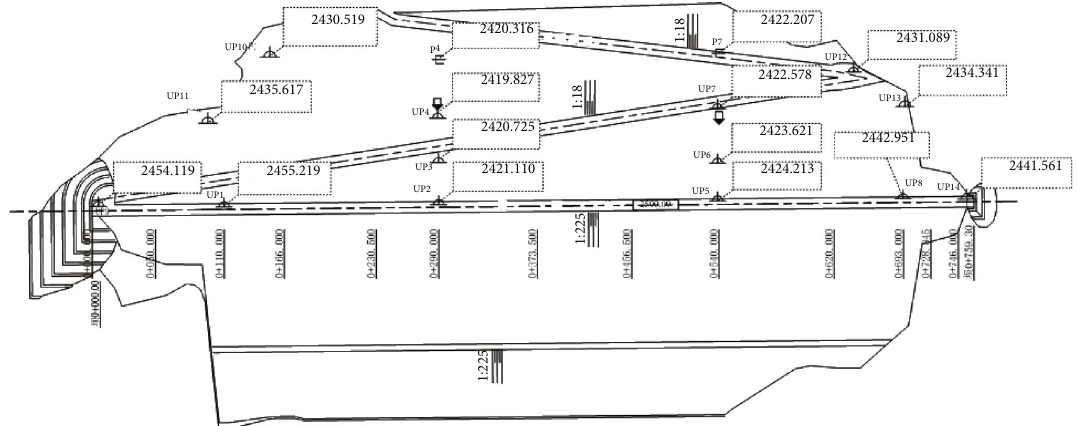
Figure 2: Planar distribution map of seepage monitoring instrument and water level.